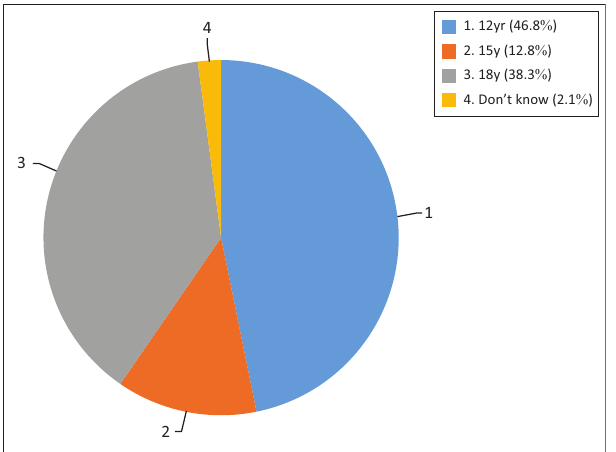
FIGURE 4: Knowledge of ‘age of consent’ to routine medical treatment.